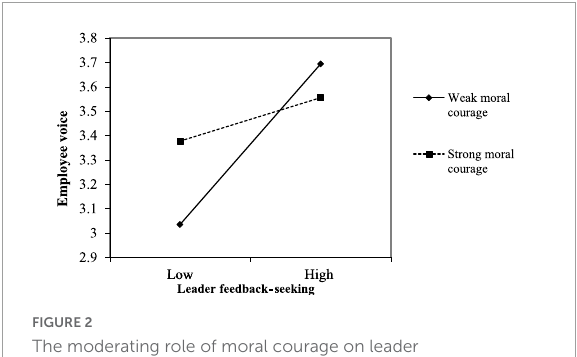
FIGURE2 The moderating role of moral courage on leader feedback-seeking and employee